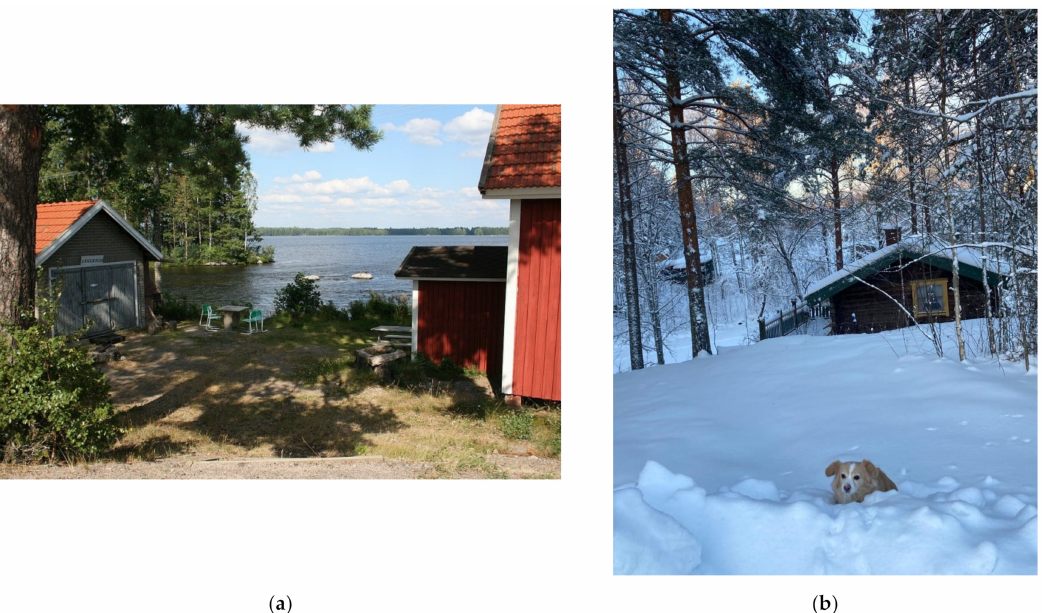
Figure 2. Cottage examples from Finland: ( a ) a summer cottage from south-east Finland (source: Wikipedia, https://commons.wikimedia.org/wiki/File:Lahnavesi-Vihannanselk%C3%A4 -Miekankoski-IMG_6938.jpg (accessed on 29 January 2022)); ( b ) a cottage from southern Finland (Photo courtesy of Jenni